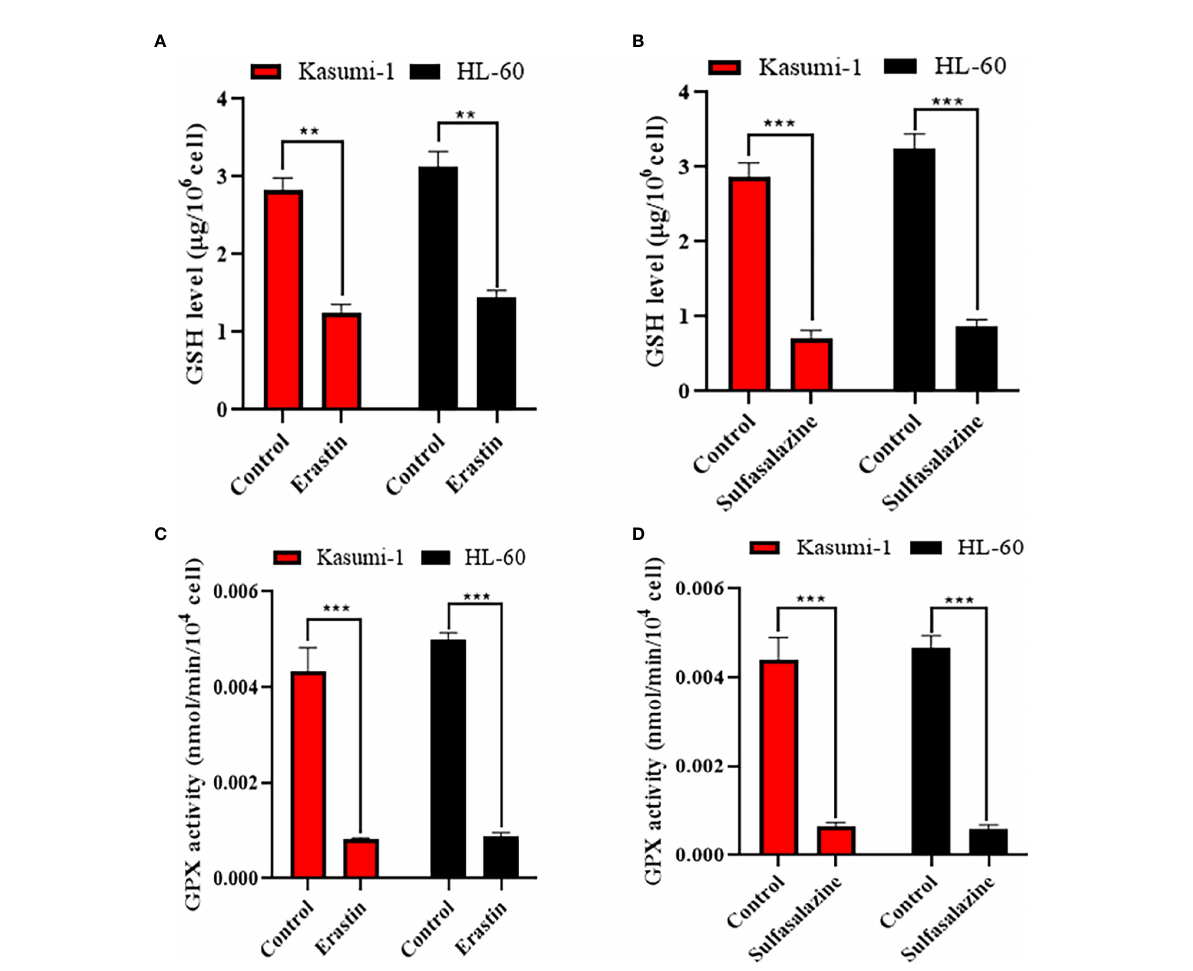
FIGURE 9 Erastin and sulfasalazine block the SLC7A11/xCT-GSH-GPX4 pathway in Kasumi-1 and HL-60 cells. (A) GSH levels were tested in Kasumi-1 and HL-60 cells cultured for 24 h under normal or 5µM erastin treatment conditions. (B) GSH levels were tested in Kasumi-1 and HL-60 cells cultured for 24 h under normal or 300µM sulfasalazine treatment conditions. (C) The activity of GPX4 was tested in Kasumi-1 and HL-60 cells cultured for 24 h under normal or 5µM erastin treatment conditions. (D) The activity of GPX4 was tested in Kasumi-1 and HL-60 cells cultured for 24 h under normal or 300µM sulfasalazine treatment conditions. NS, not signi fi cant; ** P < 0.01; *** P <